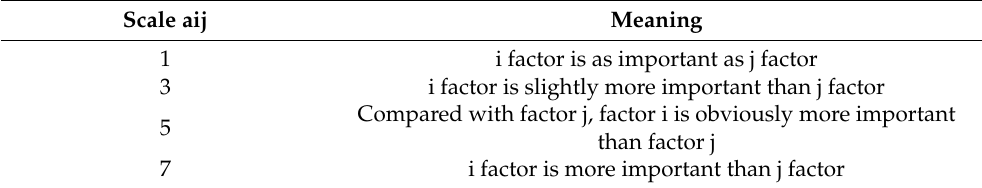
Table 2. Satty Analytic Hierarchy Process Scale